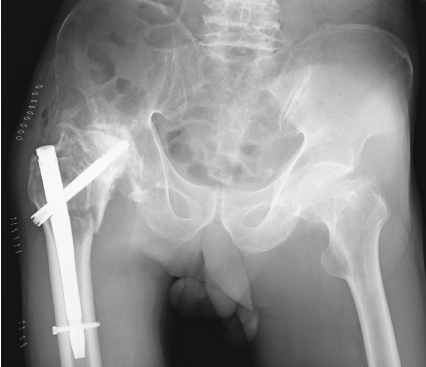
Figure 3: Anteroposterior radiograph captured after the operation showing the intertrochanteric fracture stabilized with a gamma